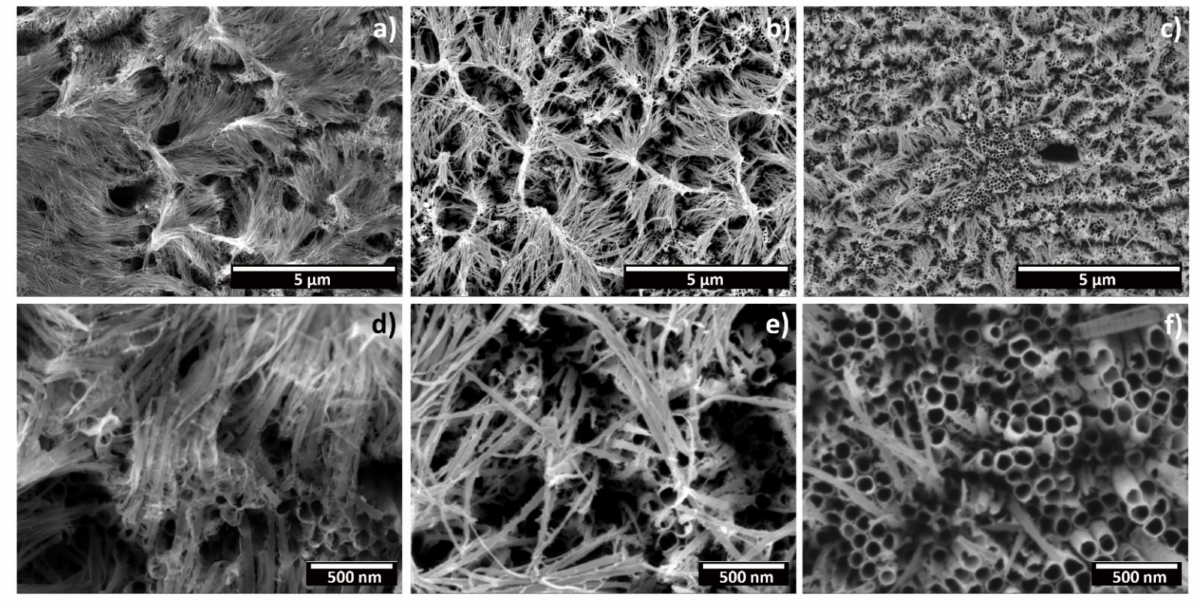
Figure 4. FESEM micrographs depicting a top view of the anodic oxide layer produced through electrochemical anodization in a CP-Ti substrate, without a post-anodizing cleaning step in an ultrasounds bath. ( a , d ) Low- and high-magnification micrographs of samples anodized in a fresh electrolyte (0 h of prior usage); ( b , e ) low- and high-magnification micrographs of samples anodized in an electrolyte with 6 h of prior usage; ( c , f ) low- and high-magnification micrographs of samples anodized in an electrolyte with 12 h of prior usage. All of the depicted samples were anodized at 40 V for 4